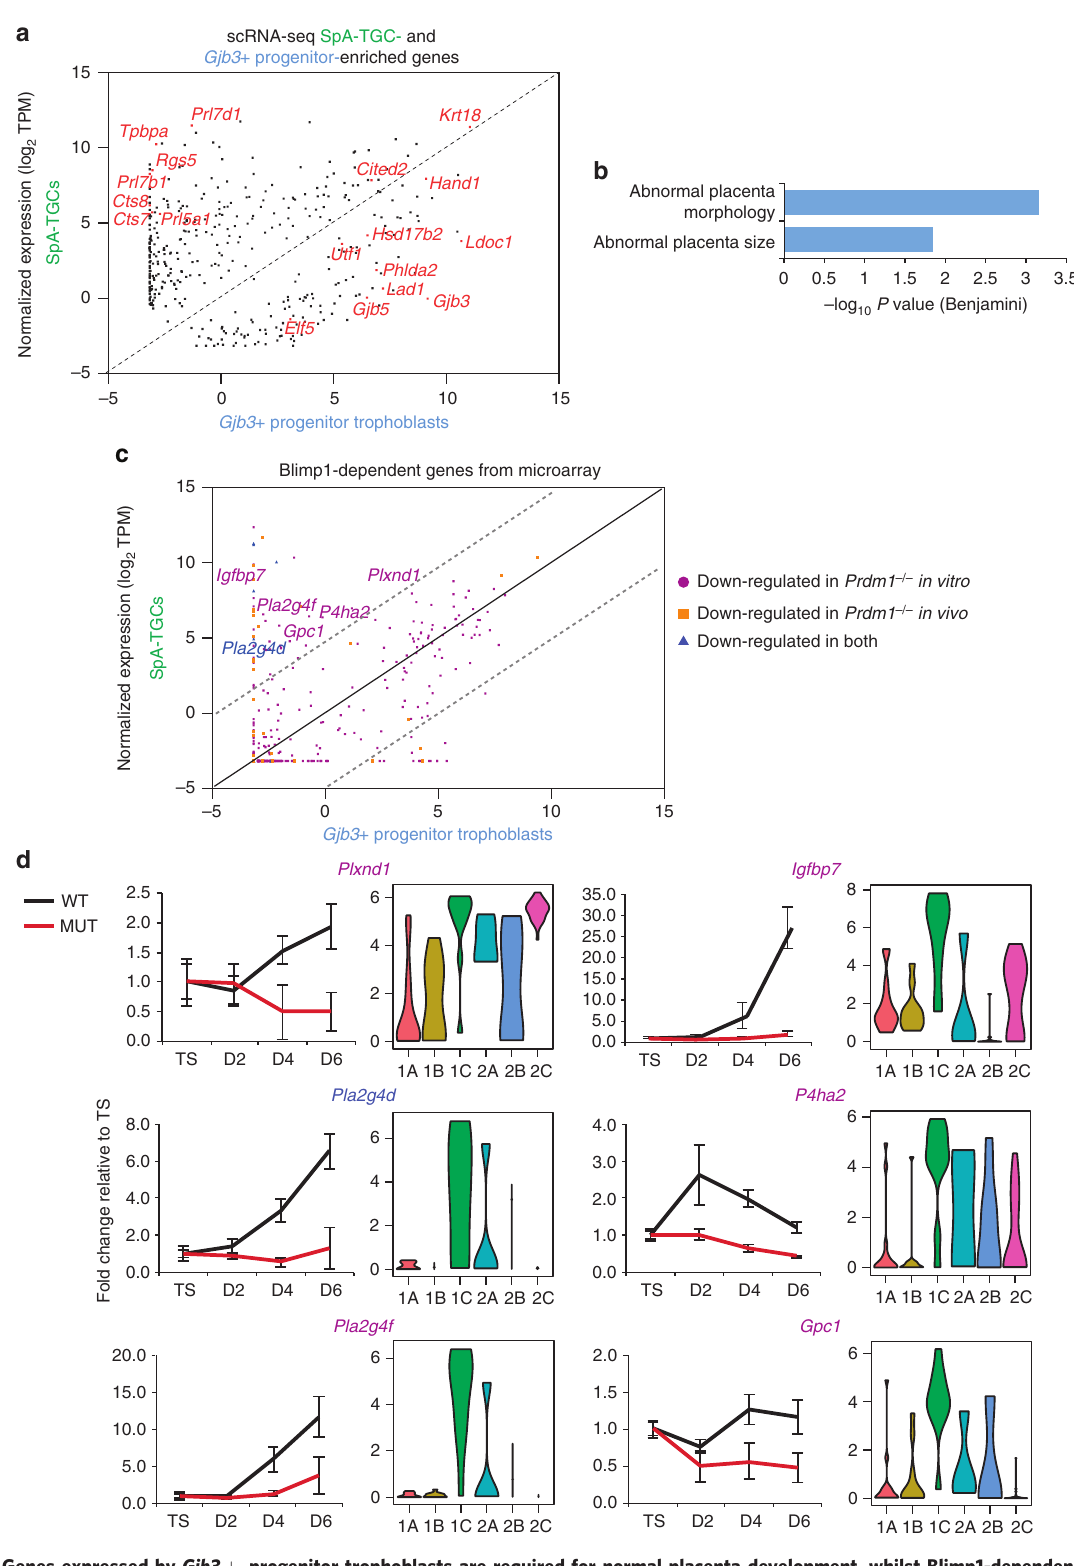
Figure 5 | Genes expressed by Gjb3 þ progenitor trophoblasts are required for normal placenta development, whilst Blimp1-dependent genes expressed by SpA-TGCs regulate vascular function. ( a ) Scatter plot of the 396 genes enriched in SpA-TGCs and Gjb3 þ progenitors presented in Figure 2c. A subset of SpA-TGC markers and genes expressed in progenitors with deleterious placental phenotypes are indicated. Plotted are mean gene expression values within each group. ( b ) Functional annotation analysis indicating MGI phenotypes associated with genes enriched in Gjb3 þ progenitors. ( c ) Scatter plot of genes downregulated in Prdm1 mutants in vivo or in vitro . Plotted are median gene expression values within each group. ( d ) Relative expression of genes downregulated in mutant and wild type TS cells during in vitro differentiation (left) in comparison with scRNA-seq data (right). Data represents mean ± s.e.m. of 6–10 samples per genotype at each